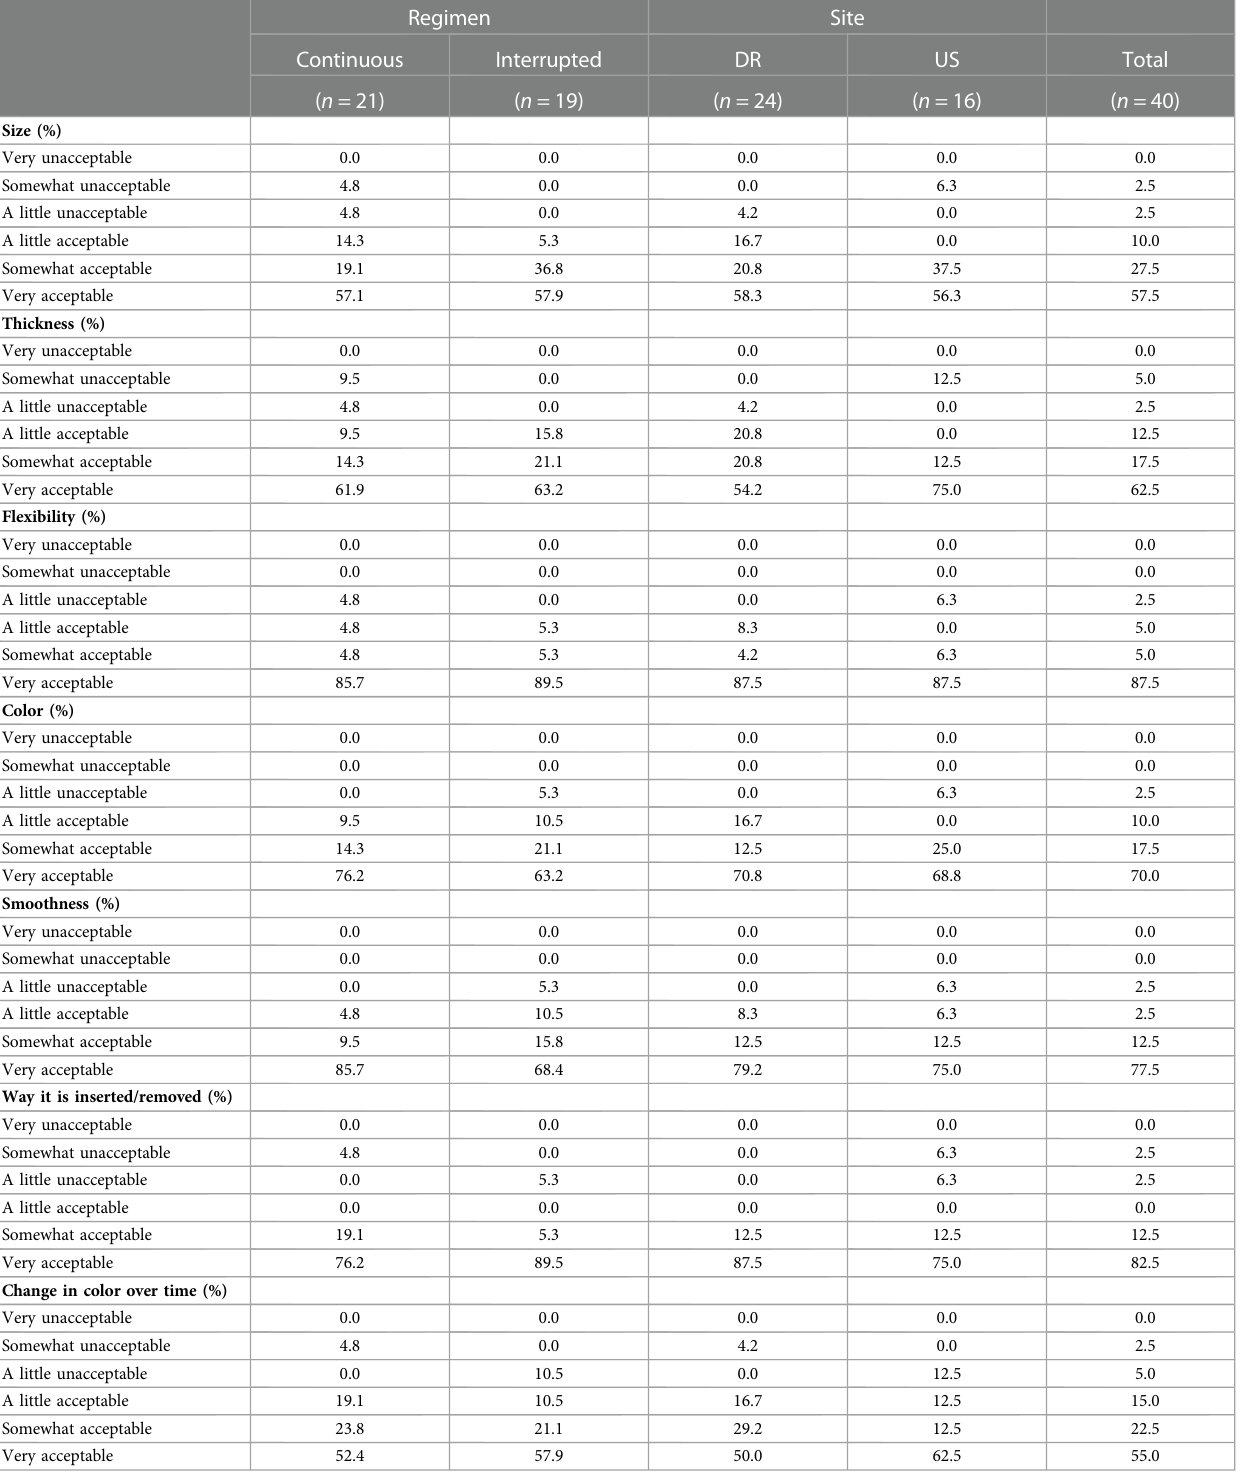
TABLE 2 Acceptability of ring characteristics by regimen and site at